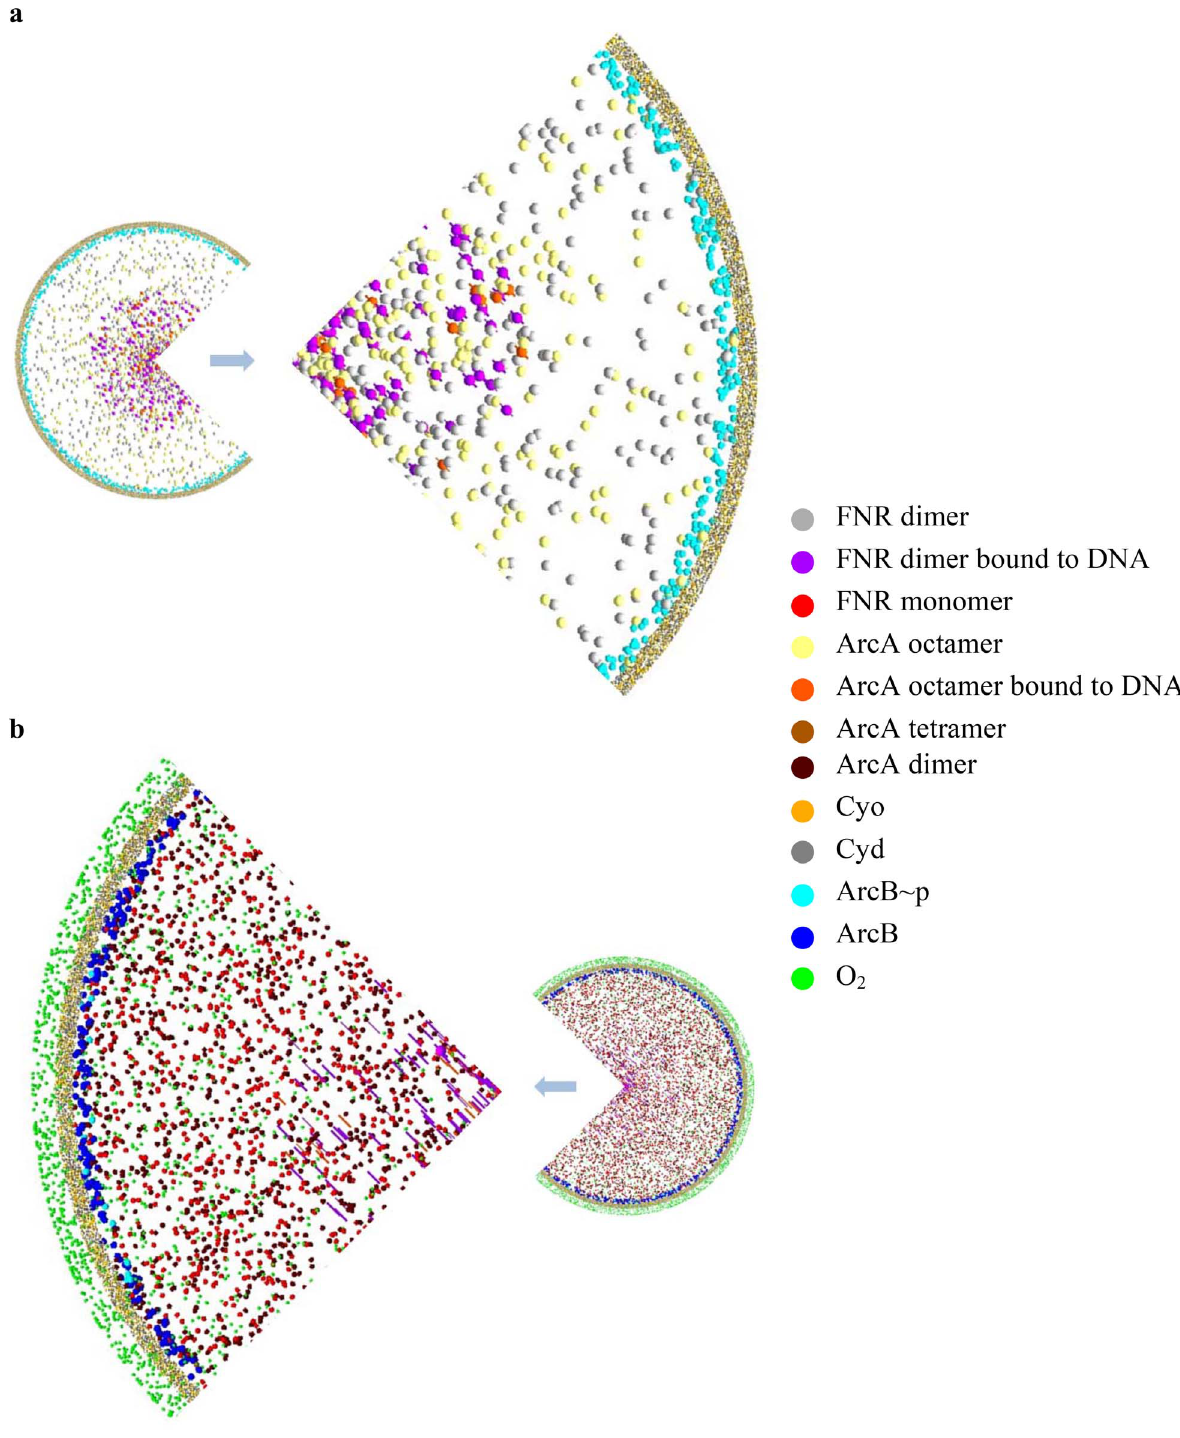
Figure 3. The initial and final states of model with no O 2 and with excess O 2 supplied. (a) The initial state of model with no O 2 (0% AU) supplied to the cell. (b) The final state of model with excess O 2 (217%) supplied to the cell. Each type of molecule is represented by a different color as shown in the key. The numbers of FNR dimer bound to binding sites and free ArcA octamers in the cytoplasm and bound to DNA did not reach FNR dimer (cytoplasmic FNR dimer) decreased when O 2 was that observed in the initial state before the second cycle of O 2 supply began, indicating that a longer period is required to return to the supplied to the system (Figures 4g–h), but the rate was slower than fermentation state. that for ArcA inactivation, consistent with O 2 consumption at the